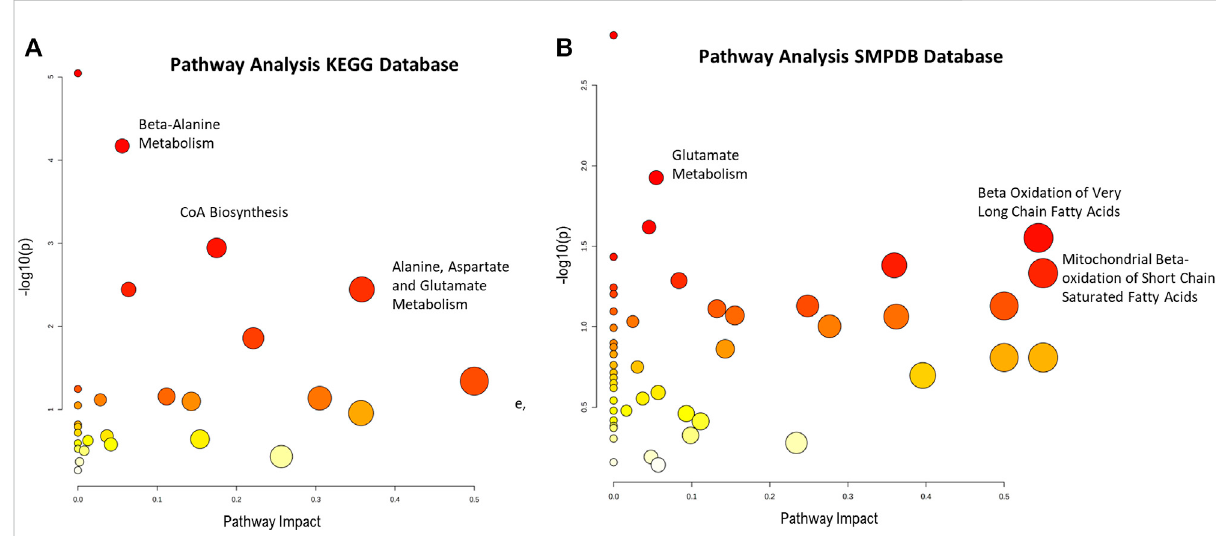
FIGURE 4 Pathway enrichment analysis from absolutely identi fi ed metabolites in (A) KEGG and (B) SPMDB databases. Graph shows the impact the statistically signi fi cant identi fi ed metabolites have in the different pathways (x-axis) together with the statistical signi fi cance of those metabolites (y-axis). Highlighted pathways have several statistically signi fi cant metabolites that in turn produce a high impact in the